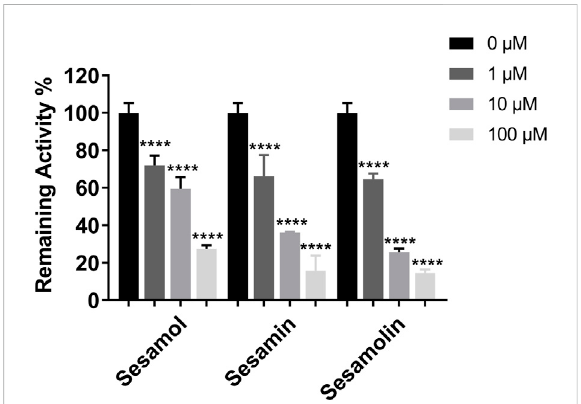
FIGURE 2 The inhibitory effects of sesame lignans on human CYP46A1 were determined using testosterone as the substrate probe. Testosterone (10 μ M) was incubated with human CYP46A1 at 37 ° C in the absence and presence of sesame lignans (0, 1, 10, and 100 μ M). Data were analyzed by one-way ANOVAandunpairedt-testsandarepresentedasmean±SDfrom three experiments carried out in duplicate. **** p < 0.0001 compared with